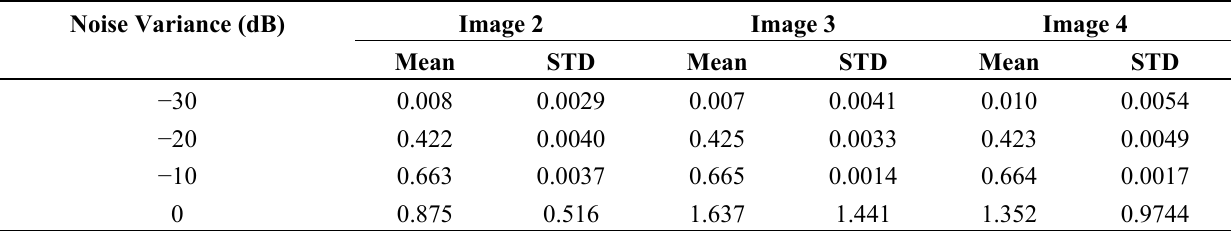
Table 8. The residual registration errors using the minimum mean square error criteria for various noise